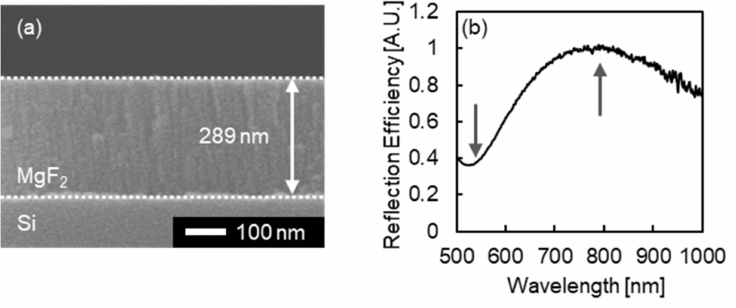
Figure 10. ( a ) Cross-sectional SEM image and ( b ) a typical thin-film interference spectrum of a MgF 2 layer deposited on a Si substrate. The gray arrows in ( b ) indicate the dip at around the 520 nm wavelength and the peak at around the 790 nm wavelength formed by thin-film